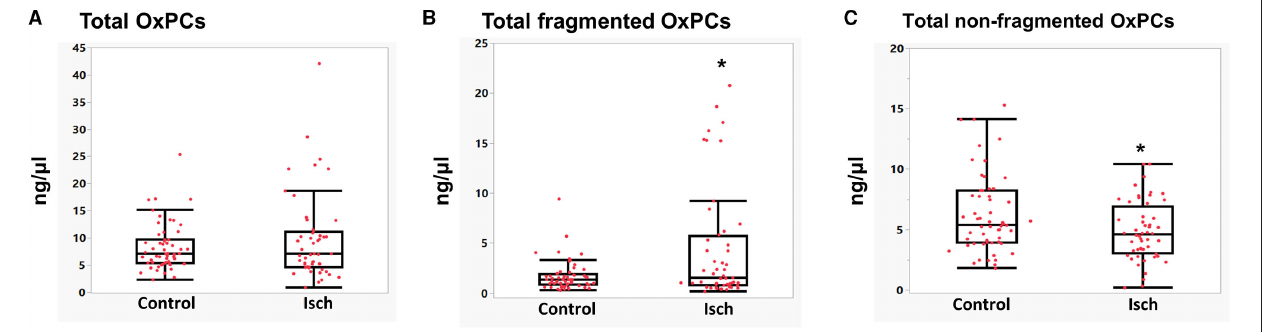
to the levels of Isch and R-2 h groups (Isch: 4.79 ± 0.94, R-2